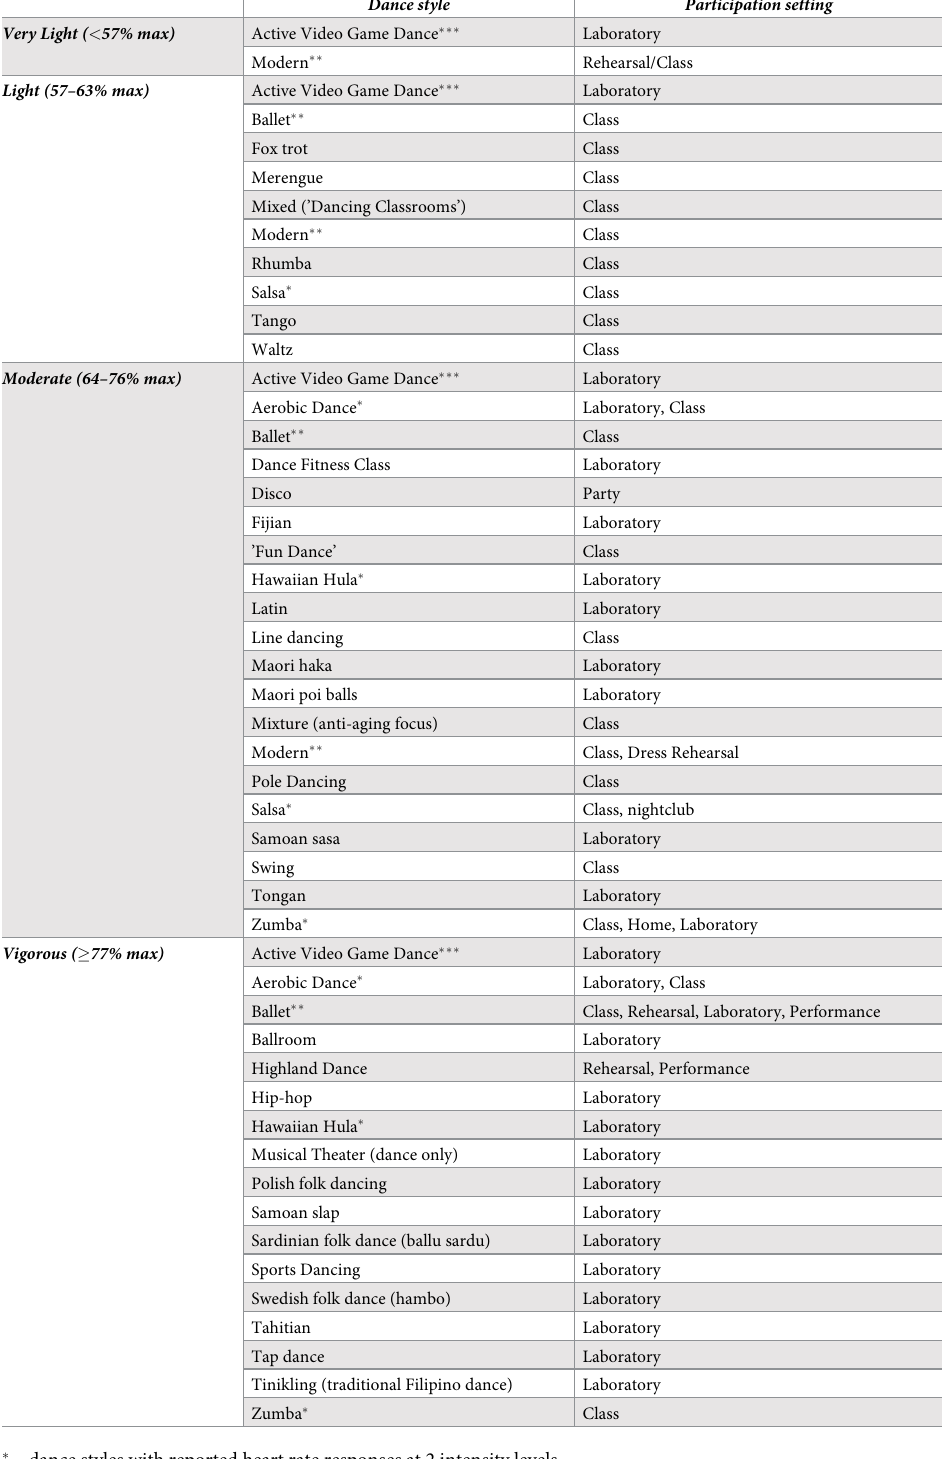
Table 4. Summary of heart rate responses to active dance participation from included